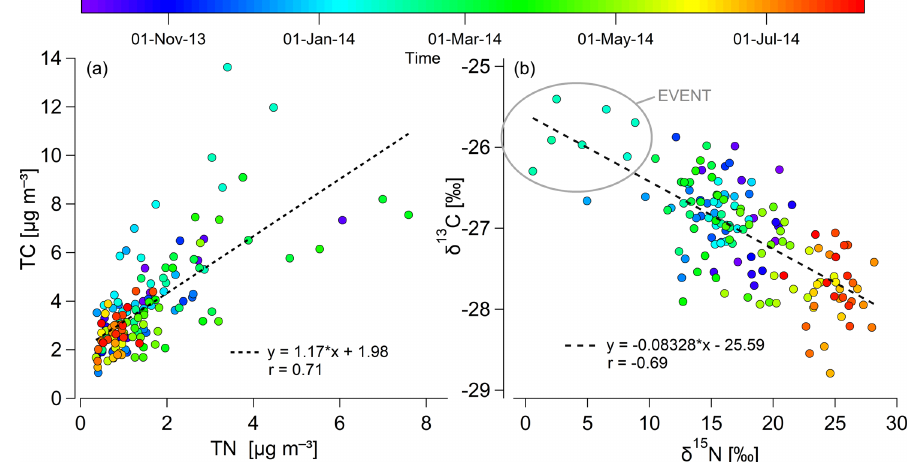
Figure 2. Relationships between TC and TN (a) and their stable carbon and nitrogen isotopes (b) . The color scale reflects the time of sample collection. The gray circle highlights the winter event measurements.